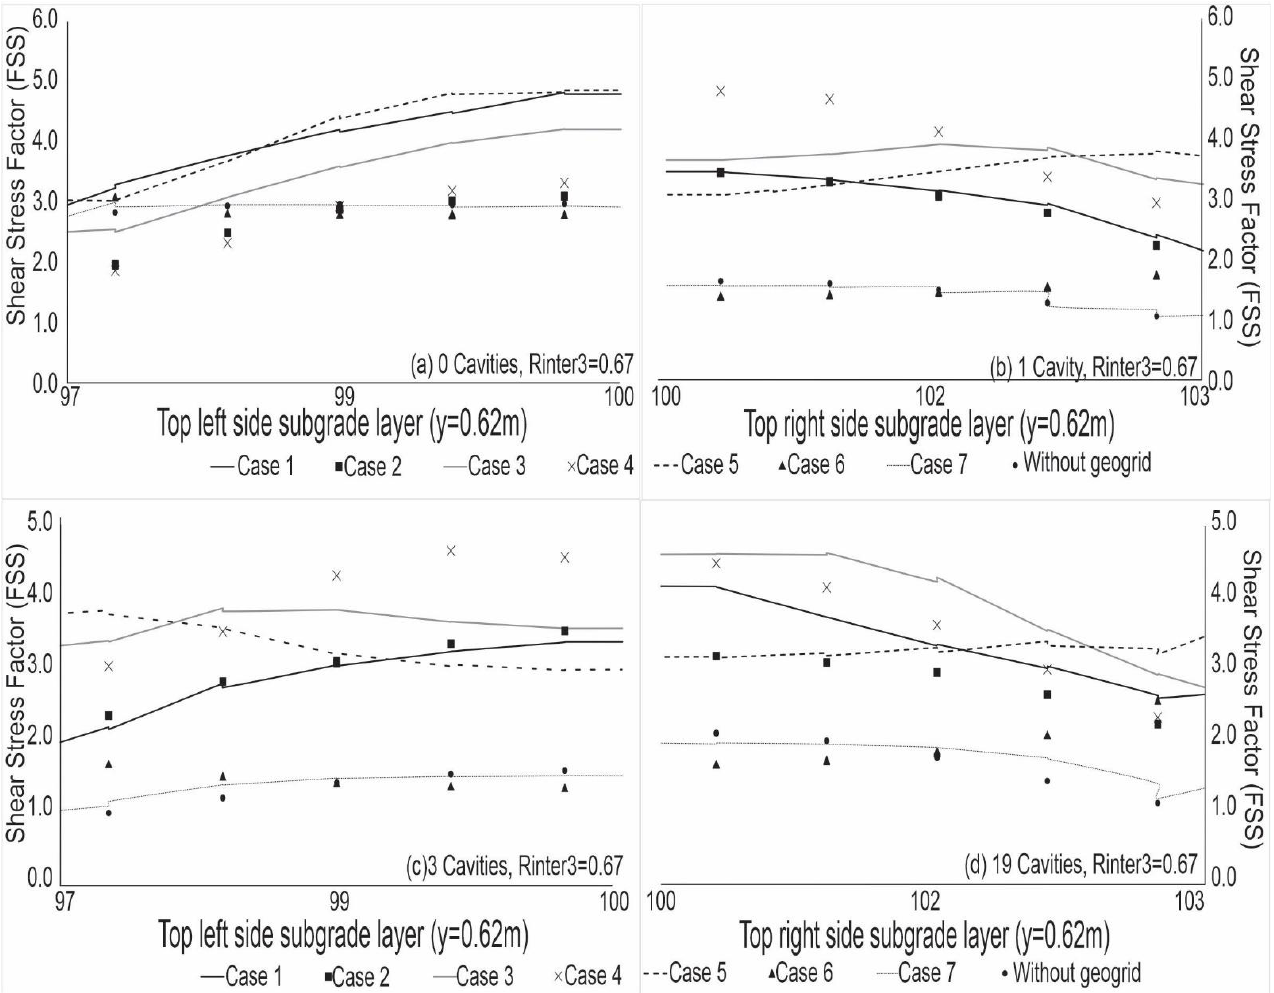
Figure 9. Graph groups of Mobilized FSS along of the subgrade layer y = 0.62 m, considering the seven Cases, R inter3 = 0.67, truck load and ( a ) 0 cavities, ( b ) 1 cavities, ( c ) 3 cavities and ( d ) 19 cavities in the soil.